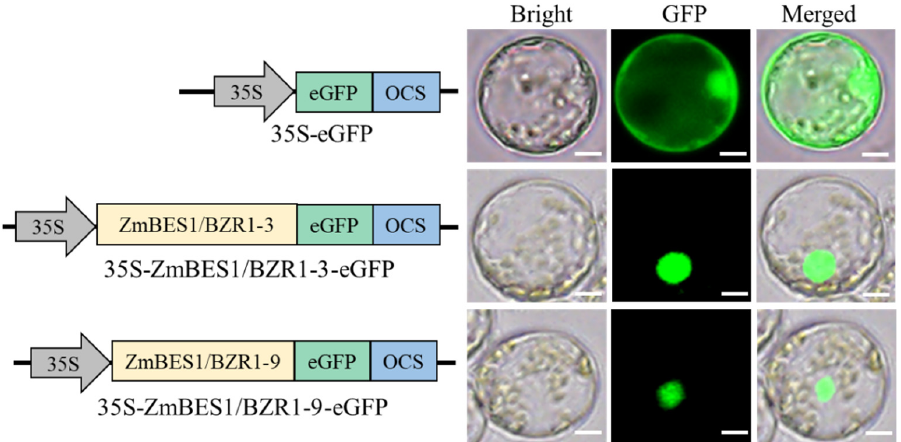
Figure 2. Subcellular localization. The ORF of ZmBES1/BZR1-3 and ZmBES1/BZR1-9 , without a stop codon, was fused to eGFP and transiently expressed in maize’s mesophyll protoplasts for 12 h. The scale bar was 20 μ m.